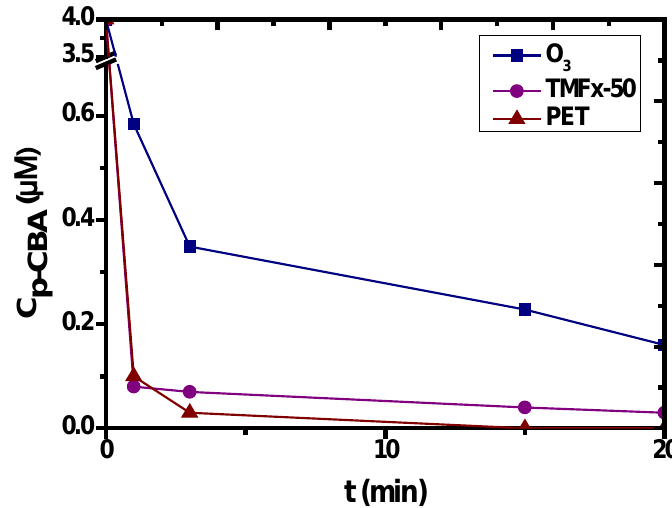
Figure 8. Catalytic ozonation with TMFx-50 and PET catalysts in comparison to single ozonation; experimental conditions: C O3 = 2 mg/L, C TMFx = 0.5 g/L, C PET = 0.5 g/L, C p‐CBA = 4 μΜ, pH = 7, T = 20 °C.